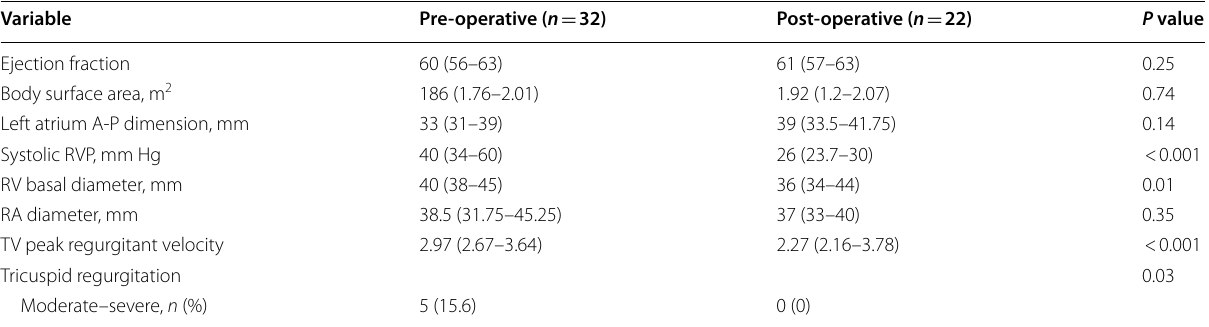
Table 6 Secondary pulmonary artery hypertension: pre-operative vs post-operative echocardiography